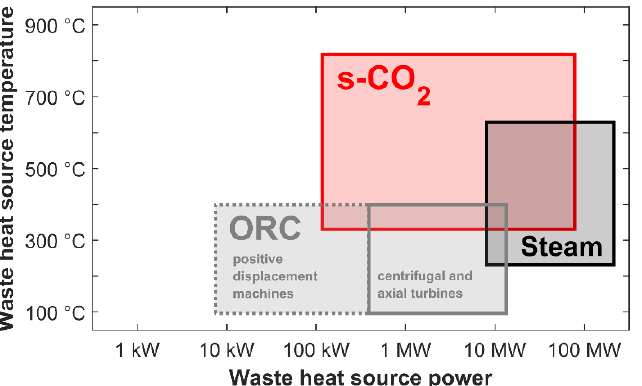
Figure 2. Comparison of different operating range of heat to power conversion technologies based on bottoming thermodynamic cycles for WHR applications (source [8]).